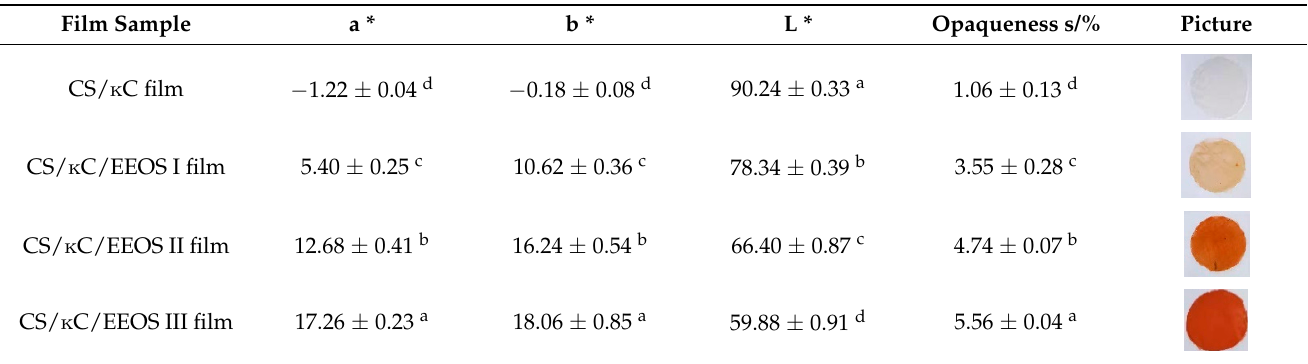
Table 1. Color parameters, opaqueness, and pictures of different EEOS concentration composite films.